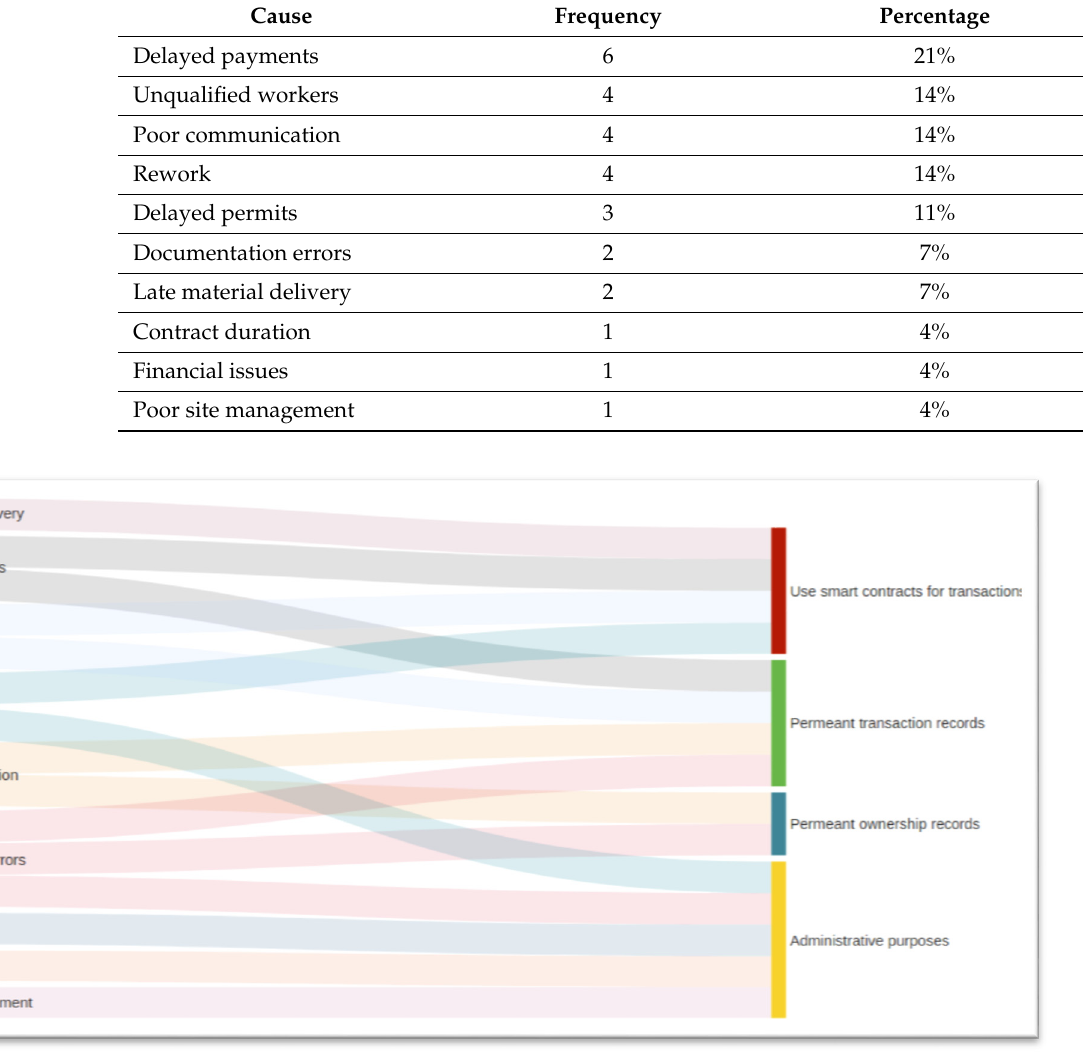
Figure 6. Snakey diagram illustrating the relationship between BCT use cases and major delays and disputes reasons.